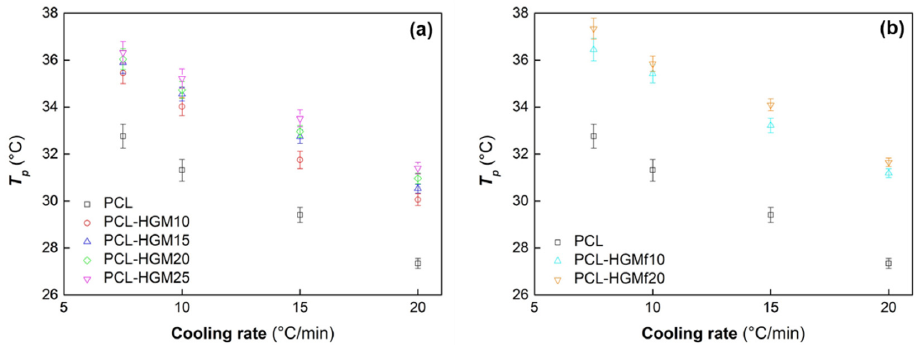
Figure 6. Peak temperatures (average values with standard deviation) for non-isothermal crystalli- zation of PCL and composites PCL-HGM ( a ) and PCL-HGMf ( b ). The nucleation activity of the untreated and silanized glass microspheres in the PCL matrix was analyzed by the theory of Dobreva and Gutzow [56,57]. This model quantifies the nucleation activity factor ( φ ) of a filler during the non-isothermal crystallization of the polymer from the melt. The nucleation activity factor is near to zero ( φ ≈ 0) when the filler is strongly active, while it tends to be near one ( φ ≈ 1) for the inert filler. At temperatures close to melting, the cooling rate for nucleation from the melt can be expressed by the following equation: ln β = const - B ∆ T p 2 (2) where β is the cooling rate, Δ T p = T m − T p is the undercooling degree and B is a parameter related to the three-dimensional nucleation. The plots of ln β versus 1/ Δ T p 2 are displayed